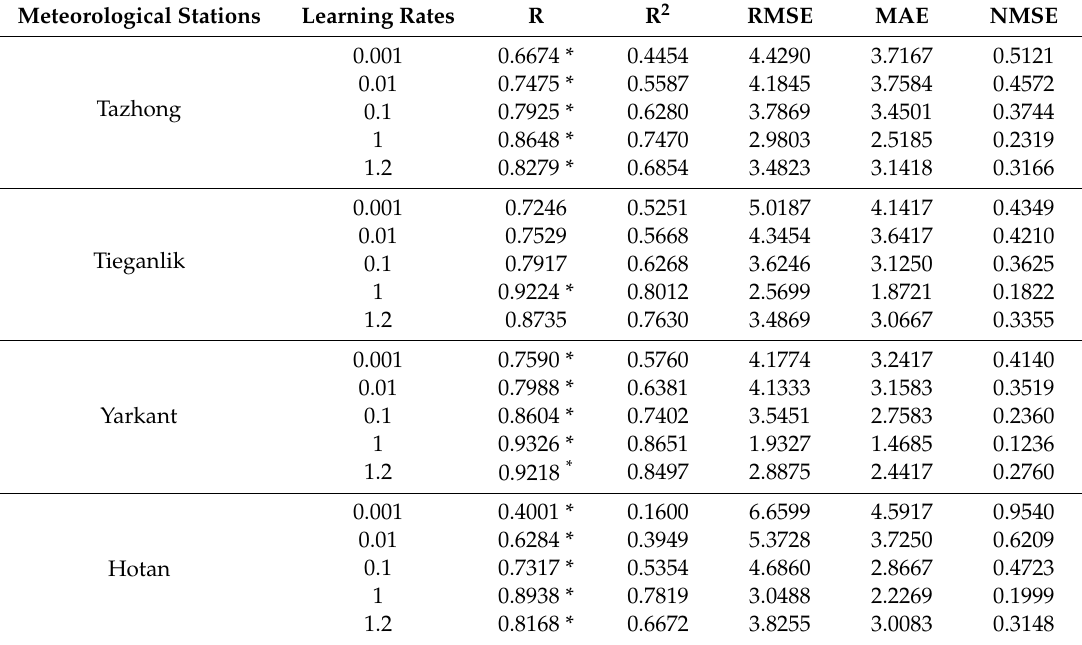
Table 1. Validation of the downscaling model based on the observation data in 2018.